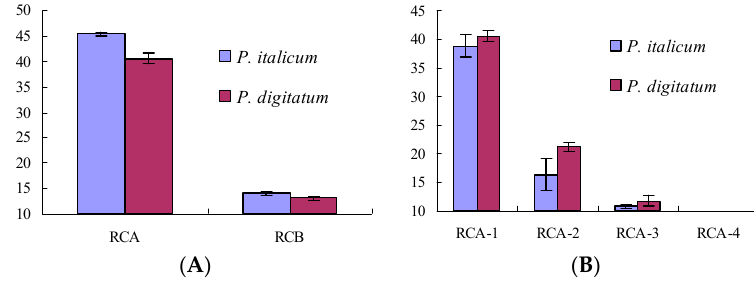
Figure 1. Antifungal activities of RC extracts ( A ) and its fractions ( B ) against P. italicum and P. digitatum. The RCA extract was fractionated into four fractions (RCA-1-RCA-4) by silica gel column chromatography. The antifungal activities of those fractions were tested with results shown in Figure 1B. RCA-1 showed stronger antifungal activity than that of other fractions ( p < 0.01), and was further investigated for antifungal